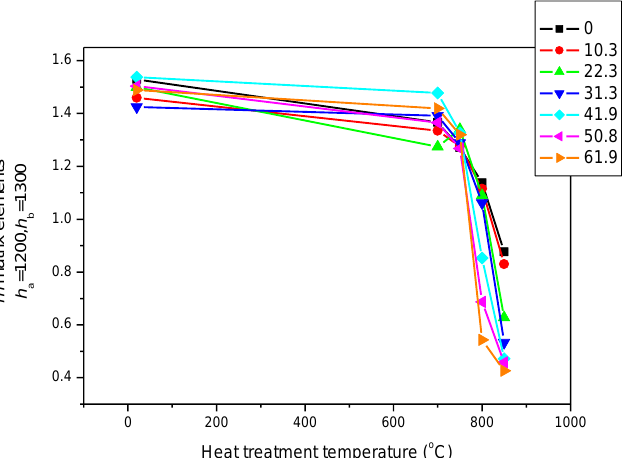
Figure 10. ( h a = 1200, h b = 1300) MAT descriptors of all samples as a function of the temperature of the heat treatment. The parameter is the rolling reduction.